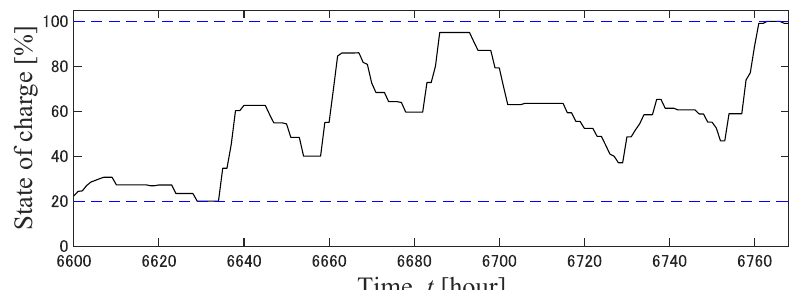
Figure 20. SOC of BESS from January 1 to 7 (Case 1).